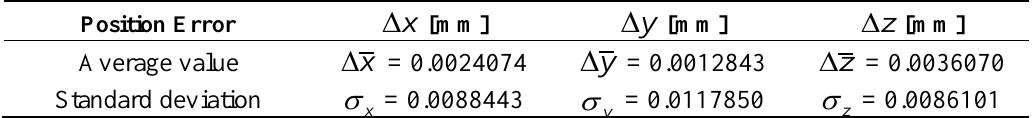
Table 1. Origin position errors between frames { E } and { E ’} for 30 robot configurations.